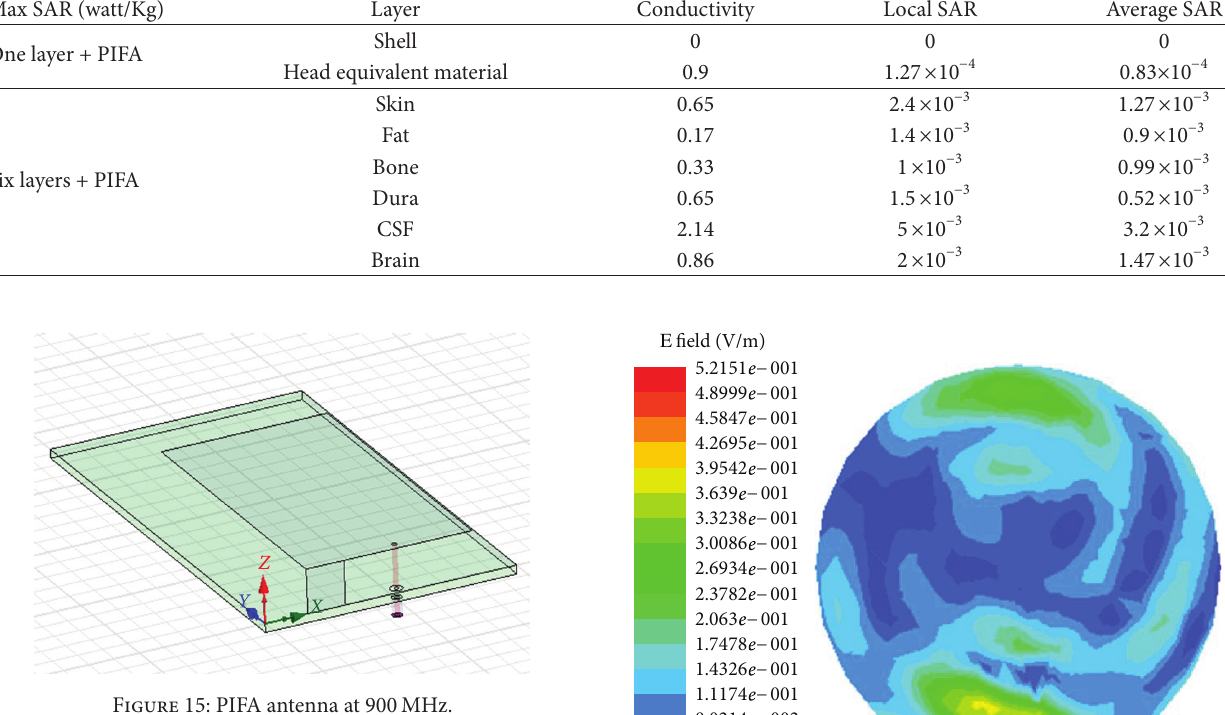
F 15: PIFA antenna at 900MHz.